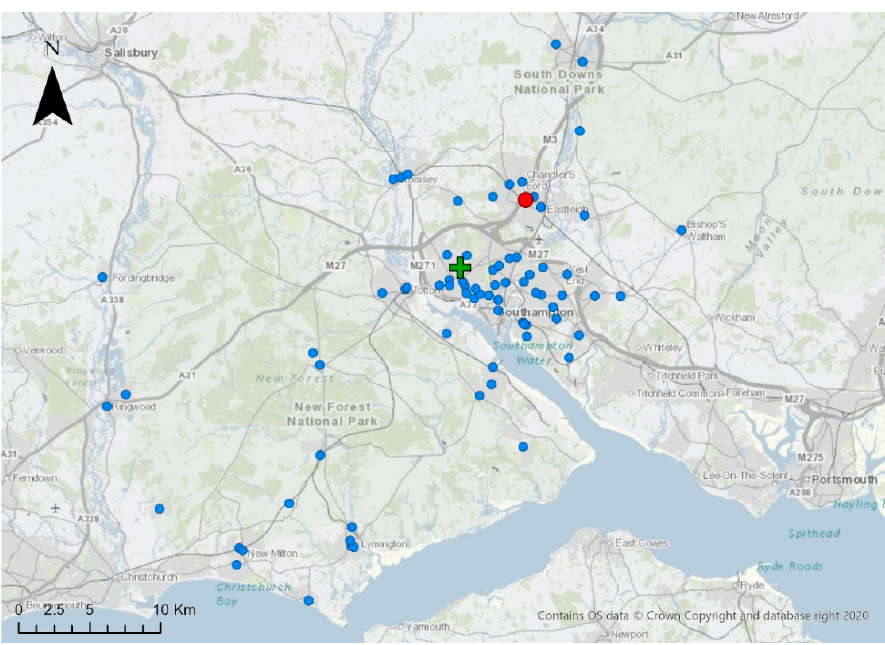
Figure 2. Map showing locations of Eastleigh PTS depot, GP surgeries and Southampton General Hospital (SGH). Red circle shows the location of Eastleigh PTS depot, blue circles show locations of GP surgeries and green cross shows the location of SGH.